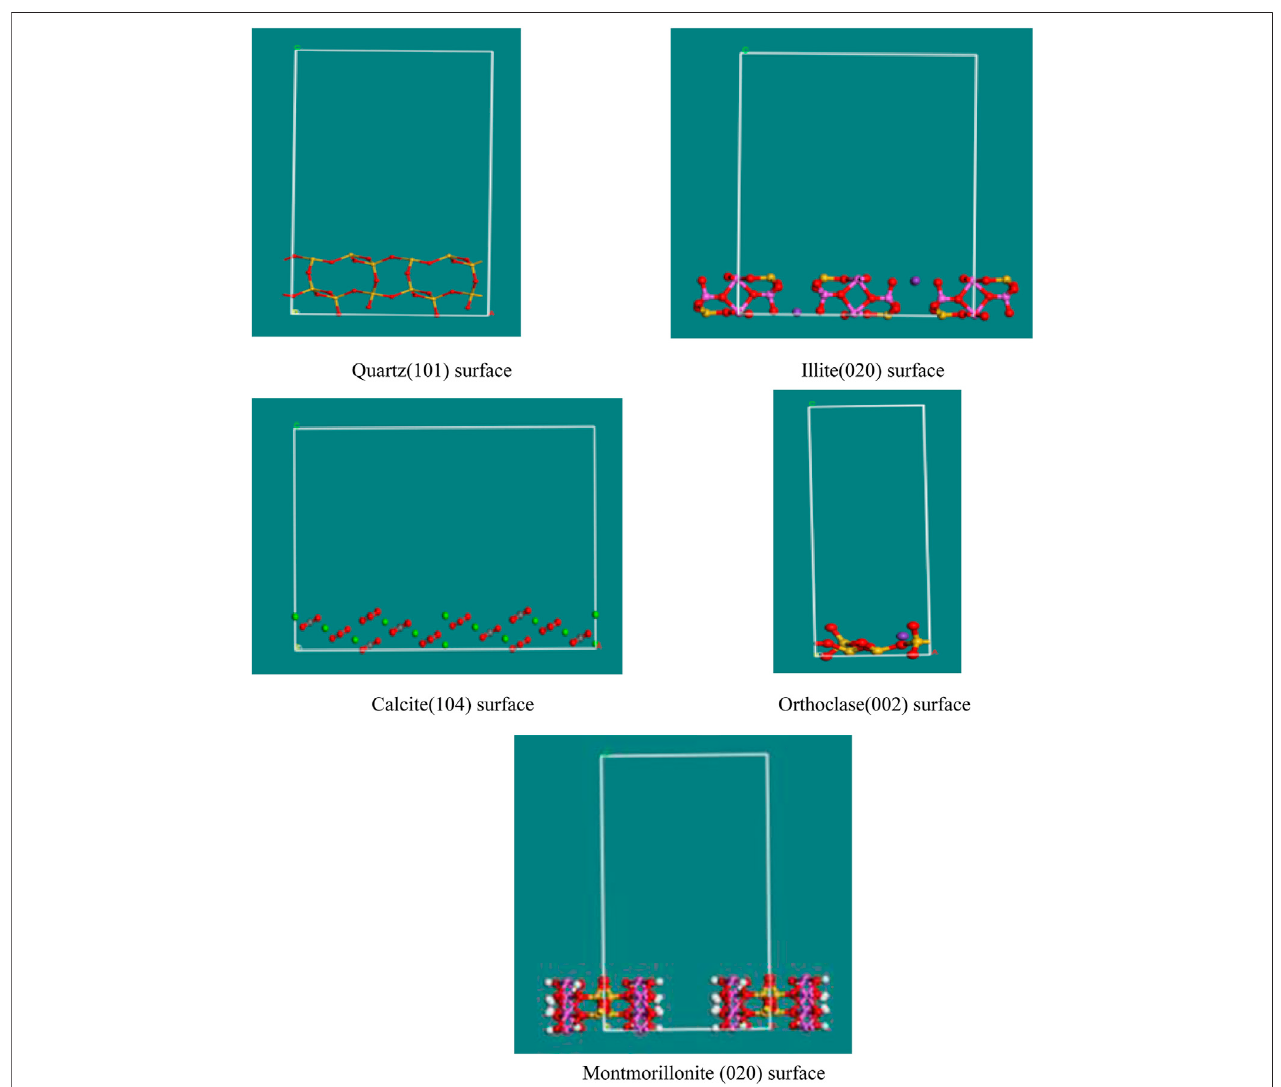
FIGURE 1 | Models of the different crystal planes for the clay minerals adopted in the text.